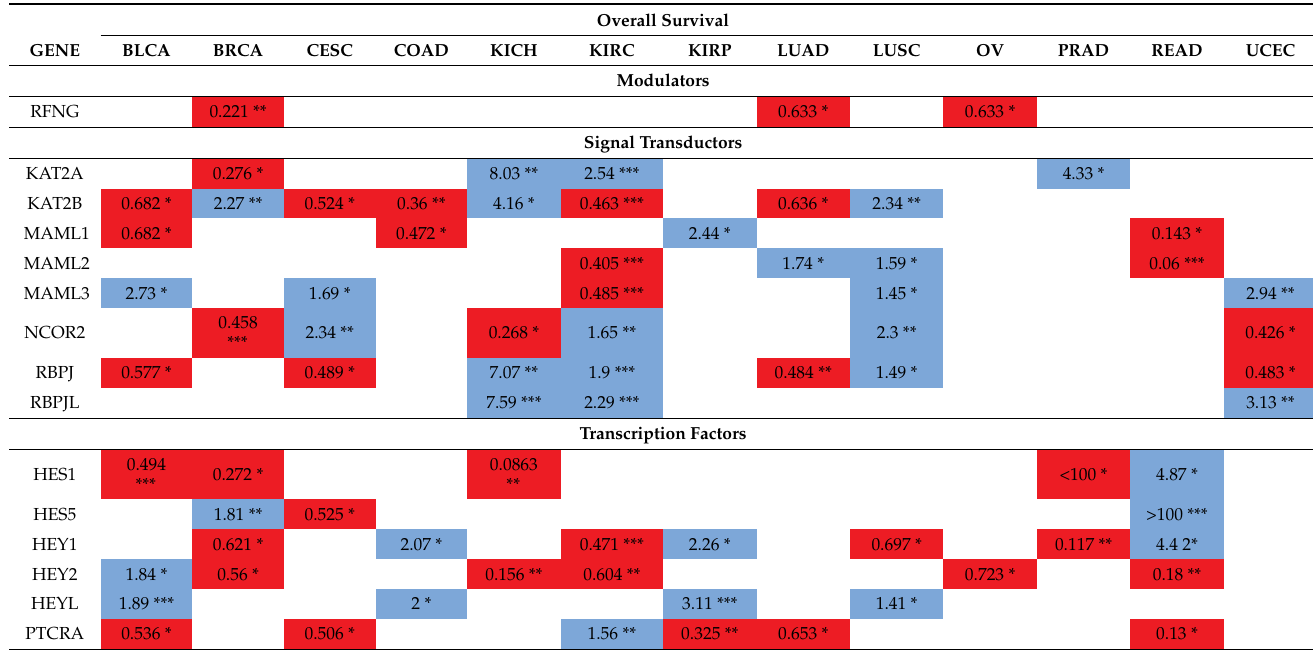
Table 3. Cont. Overall Survival